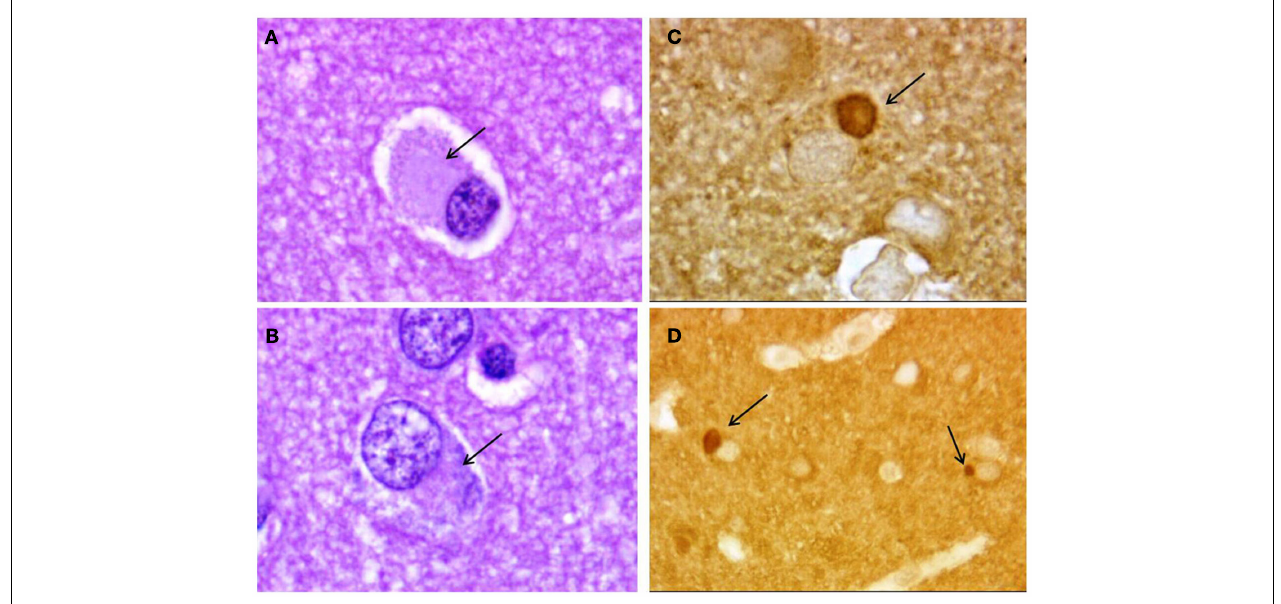
FIGURE 4 | Neuropathology of Pick’s disease. Pick bodies ( arrows ) in frontal cortex. (A,B) Hematoxylin–eosin; (C,D) tau immunostaining. Magnification, 1000 × (A–C) , 400 × (D) .